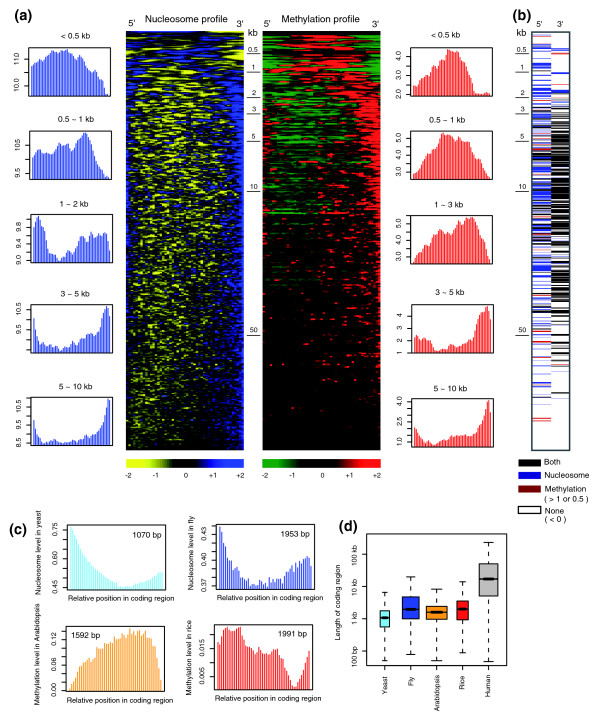
Epigenetic characteristics within coding regions of varying size. (a) Heatmaps showing the coding-region profiles of nucleosomes (left side) or methylation (right side) averaged over 100 neighboring genes ordered by size. A total of 25,883 genes were used. Each row represents a mean-centered profile for each gene. The average profile of genes of similar size is given on the left side (for nucleosome level) and the right side (for methylation level) of the heatmap. (b) A combined profile of the heatmap signatures of the two marks at each end (marks > 0.5 at the 5' end and > 1 at the 3' end were considered significant). (c) Genome-wide average of nucleosome occupancy in yeast and fly (upper panels) and methylation level in Arabidopsis and rice (lower panels) according to relative positions within the coding region. The median length of coding regions is shown. (d) Size of coding regions from each species. The box width is proportional to the square root of the number of measured genes.